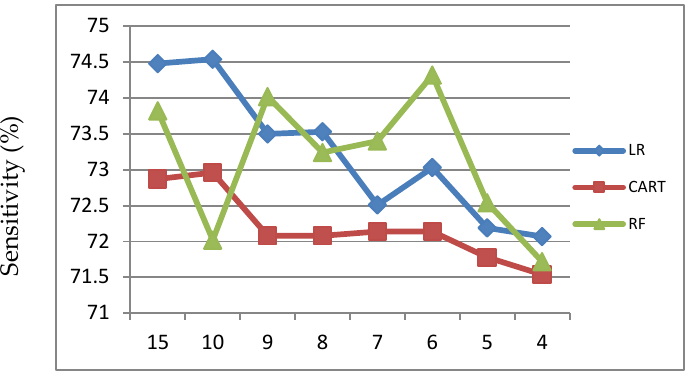
Figure 7. Accuracy of LR, CART and RF with input of important variables identified by RF.